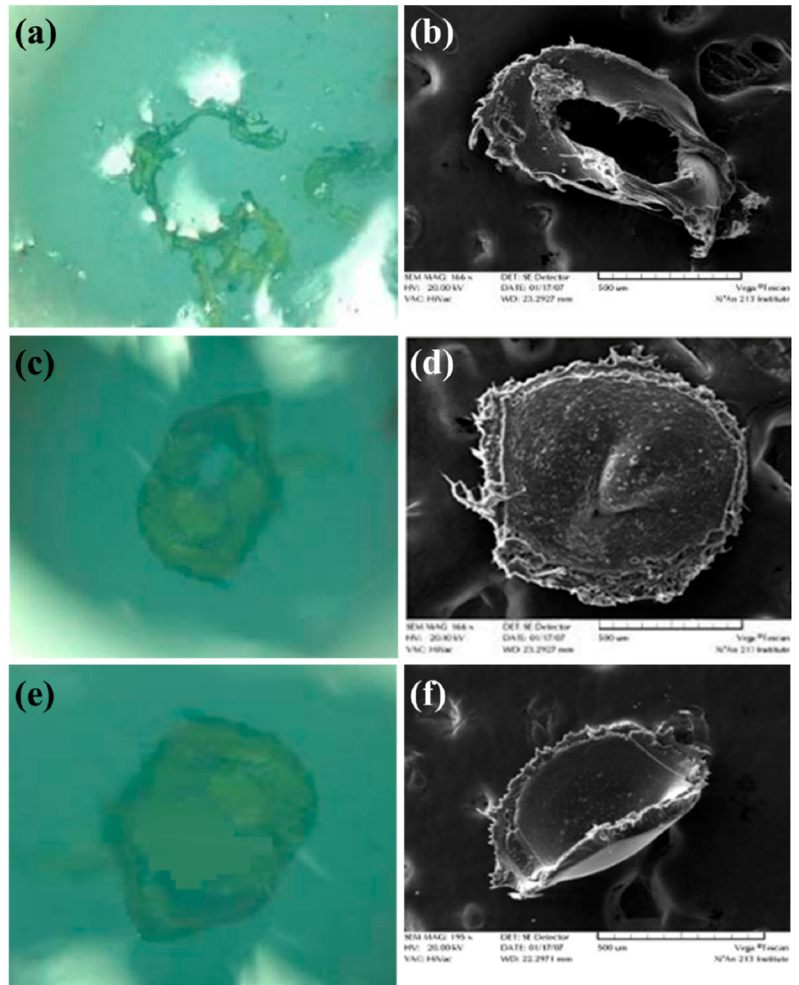
Figure 11. The morphology of flyers (2.0 kV): ( a , b ) Sample A, ( c , d ) Sample B, and ( e , f ) Sample